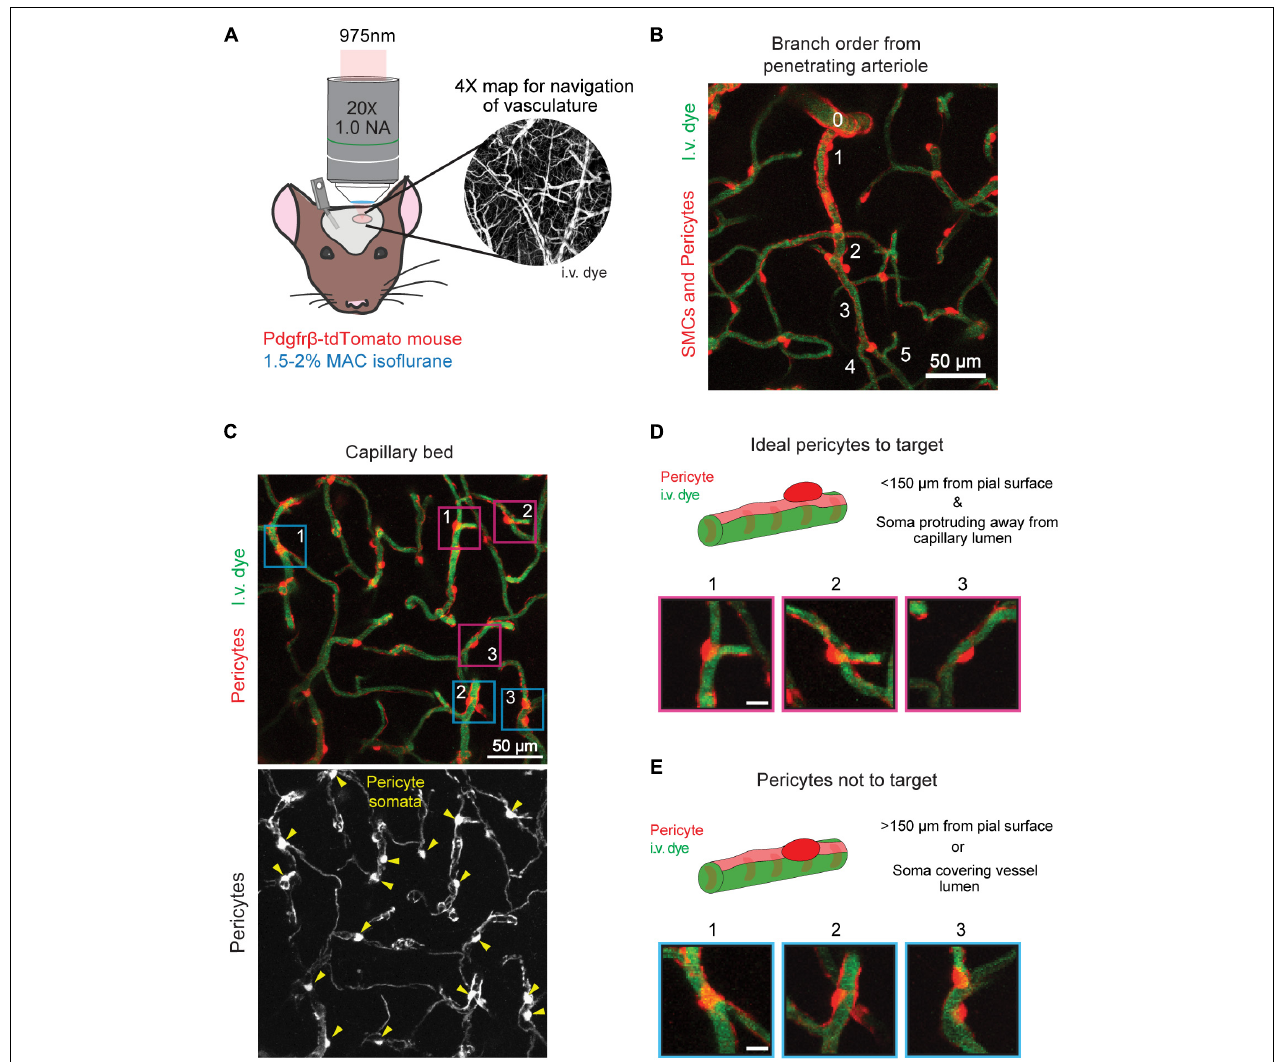
FIGURE 1 | Selecting a pericyte for optical ablation. (A) In vivo two-photon imaging of an anesthetized PDGFR β -tdTomato mouse with a 975 nm laser. Inset shows the 4X cranial window map used for navigation of the vasculature. (B) A penetrating arteriole (0) branching to form the arteriole-capillary transition zone ( ∼ 1–3 branch order), which further branches to form the capillary bed ( ≥ 4 branch orders). Thin-strand pericytes are found in the capillary bed. Pericytes are shown in red, and vessels are shown in green. (C) Capillary bed in the mouse cerebral cortex. Pericytes are labeled in red, and vessels are labeled in green. Lower panel shows pericytes in greyscale with yellow arrowheads indicating location of pericyte somata. Ideal pericytes to target are centered inside fuchsia boxes and pericytes that should not be targeted are centered in blue boxes. (D) Ideal pericytes to target for optical ablation. The schematic and following examples (1–3) contain a round pericyte soma that protrudes off the vessel wall. The fuchsia boxes in (C) correspond to each example. Scale bar = 10 µ m. (E) Pericytes that should not be targeted for optical ablation. The schematic and following examples (1–3) contain a cell body that overlaps with an underlying vessel. The blue boxes in (C) correspond to each example. Pericytes are shown in red, and vessels are shown in green. Scale bar = 10 µ